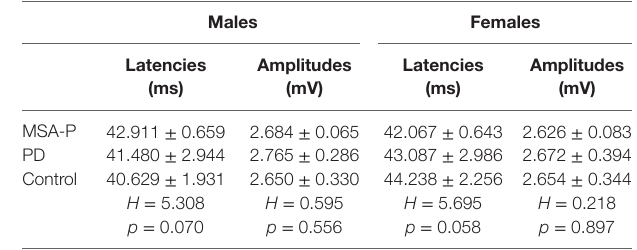
TaBle 4 | Comparison of the mean pudendal nerve somatosensory-evoked potential responses P41 latencies and amplitudes between multiple system atrophy with predominant parkinsonism (MSA-P), Parkinson’s disease (PD), and control groups. Males